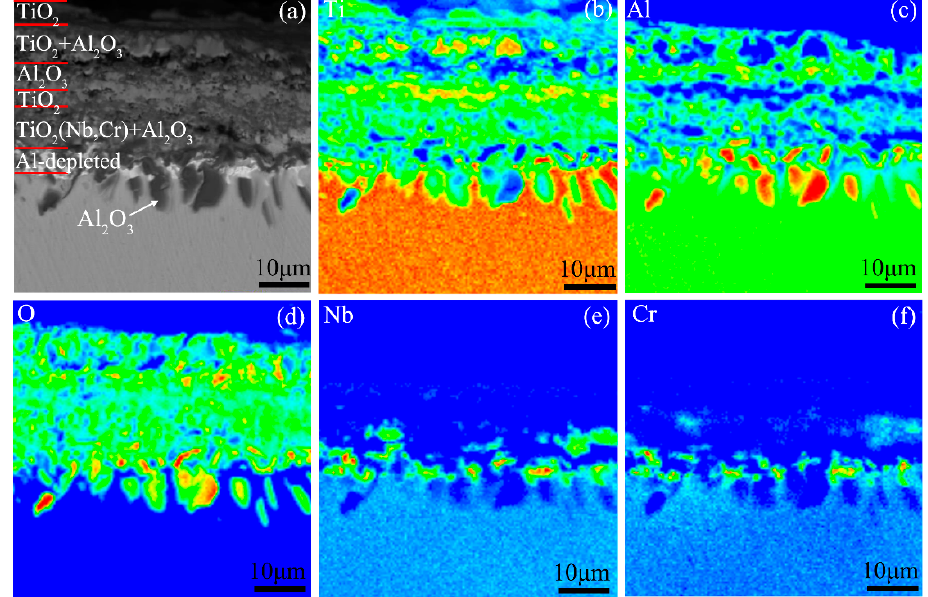
Figure 10. ( a ) Cross-sectional morphology and ( b – f ) the corresponding elemental distribution maps of the oxide scale formed during heating the Ti-46Al-2Cr-5Nb alloy to the end of Stage IV.